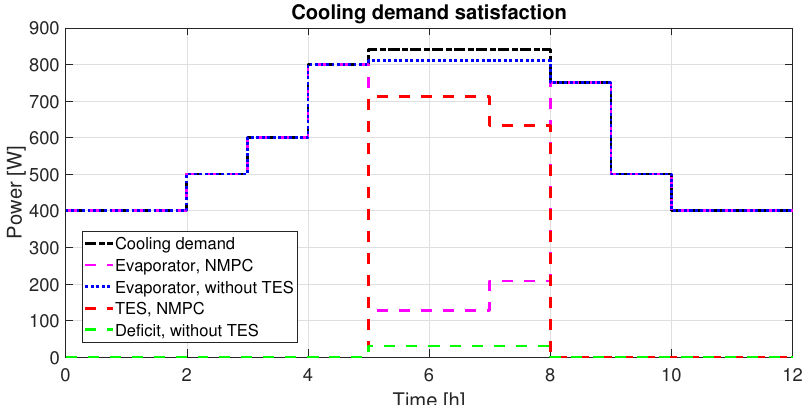
Figure 12. Comparison of the cooling demand satisfaction between the proposed NMPC-based scheduling strategy and the refrigeration cycle without energy